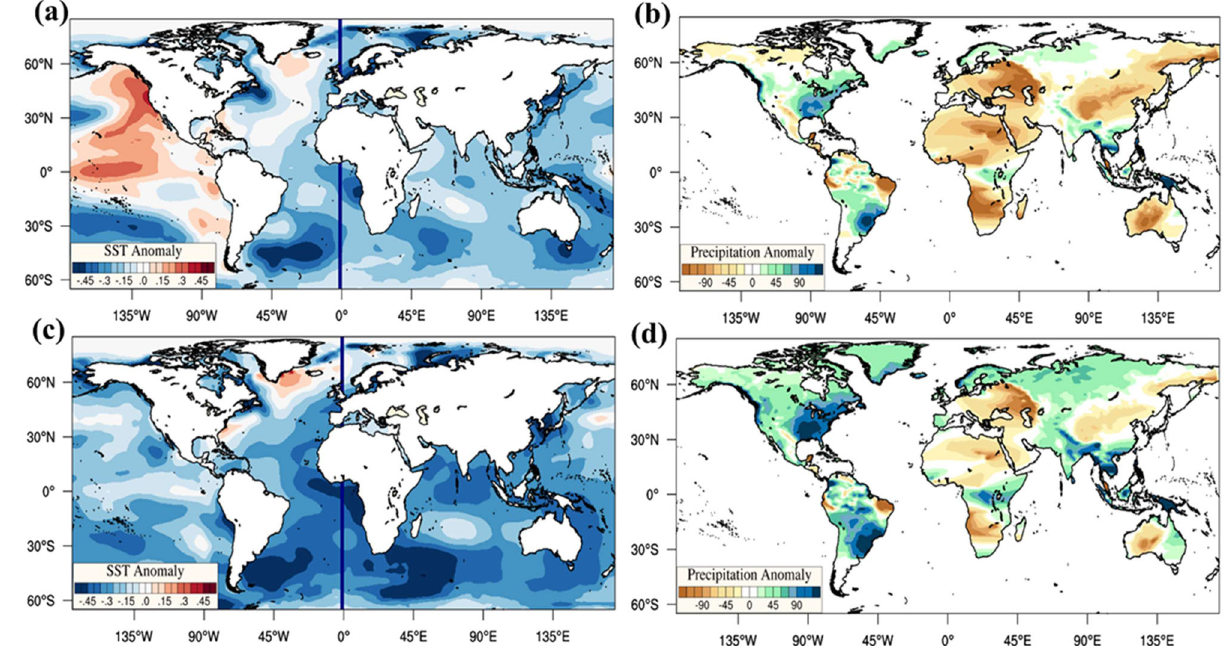
Fig. 4 | El Nino Southern Oscillations (ENSO)drivingdrought-rich periods over subtropical regions ofsouthern hemisphere. a , c Sea surface temperature (SST) anomaly b , d Precipitationanomalywhen( a , b )droughtisoccurringinboth(~AND logical condition) of the chosen regions and drought is occurring in at least (~OR logical condition) one of the chosen regions ( c , d ). The anomaly of